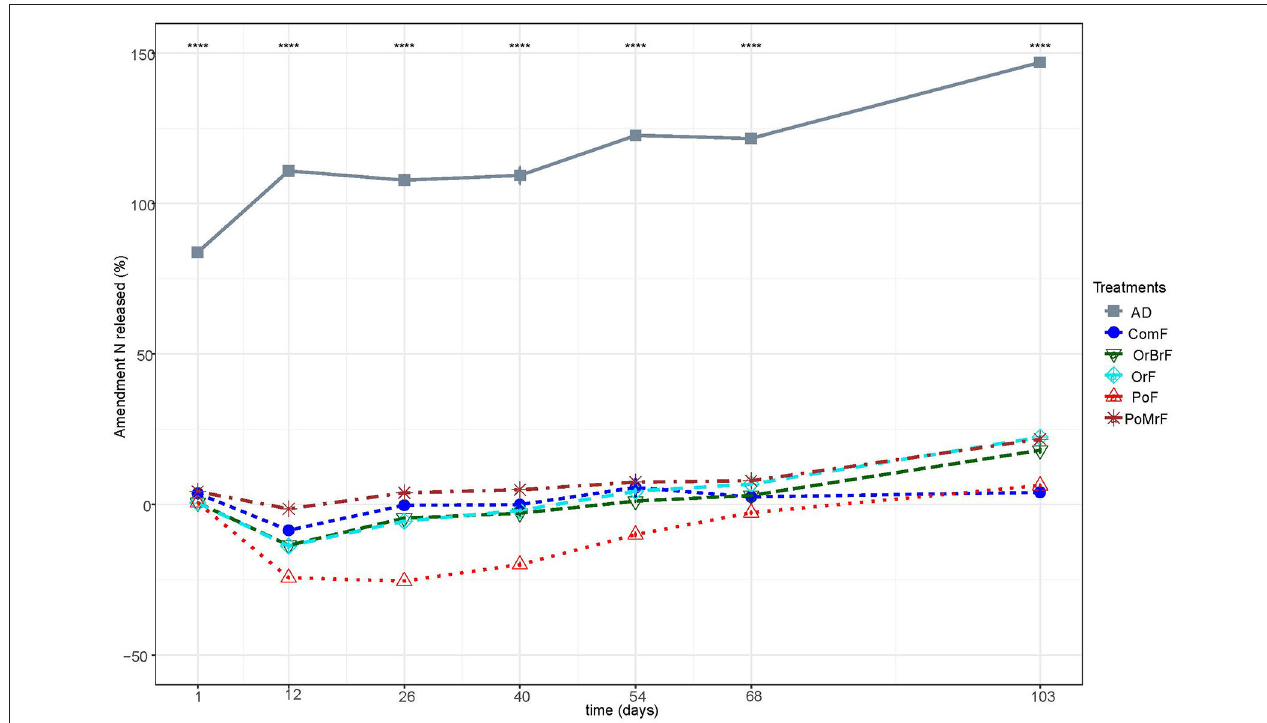
FIGURE 3 | Dynamics of net N released from the bio-based fertilizers expressed as a percentage of total N added in each treatment. ****, significant statistical differences ( p < 0.001).